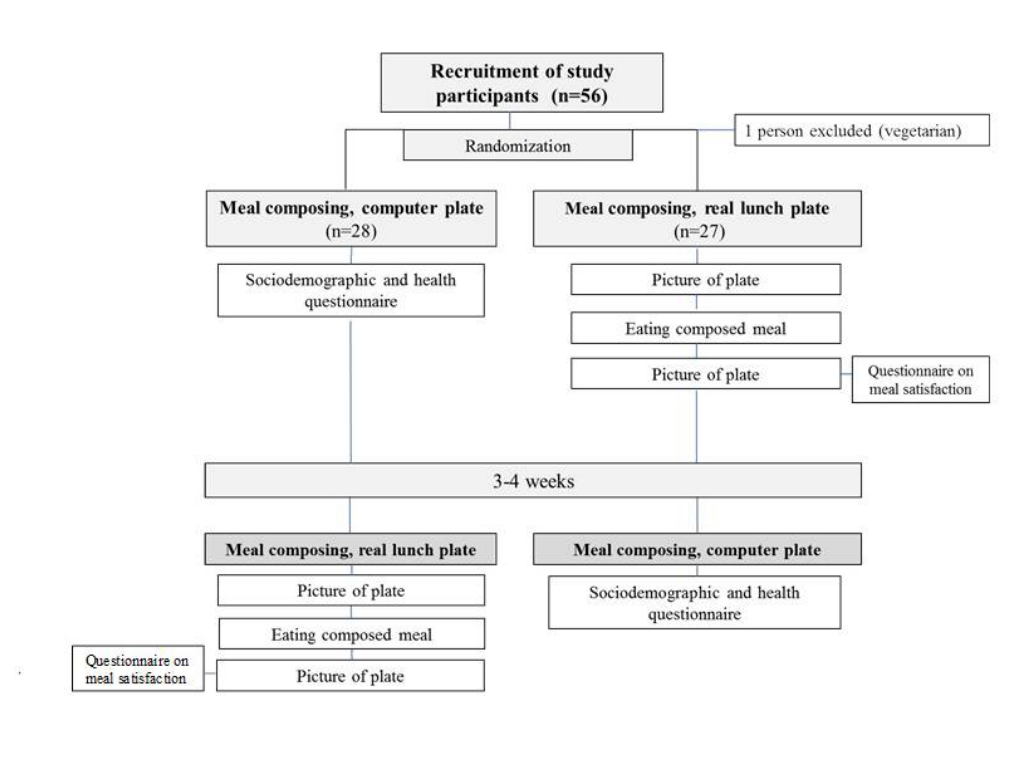
Figure 1. Flowchart of the validation